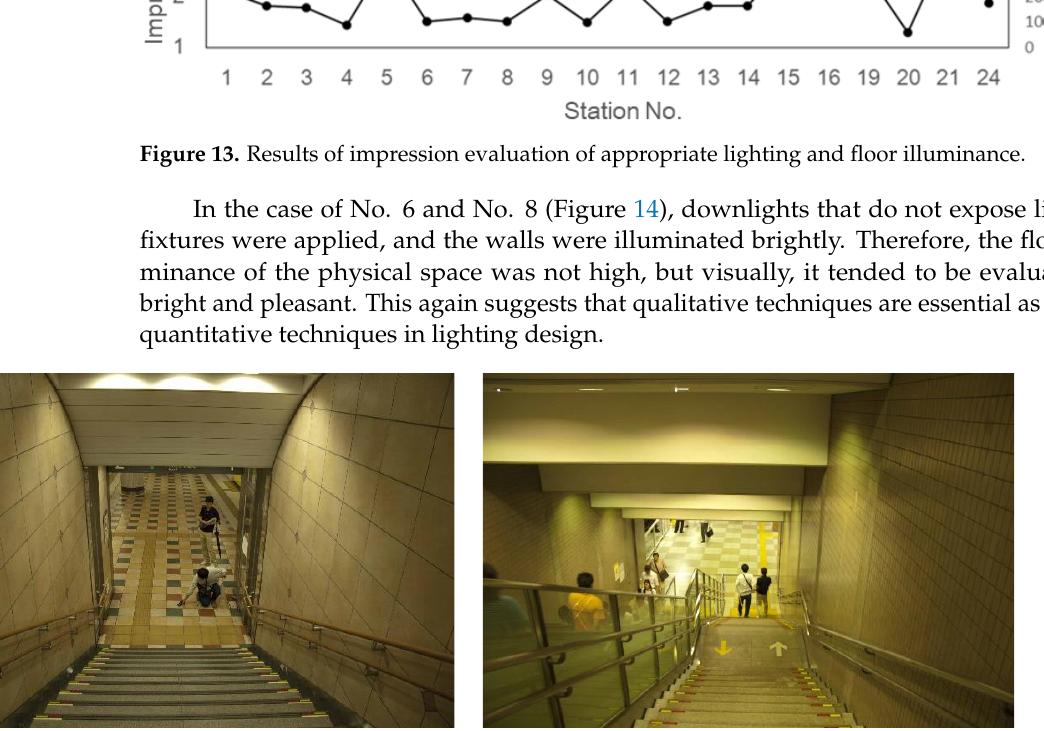
Figure 14. Front views of the No. 6 ( left ) and No. 8 ( right ).